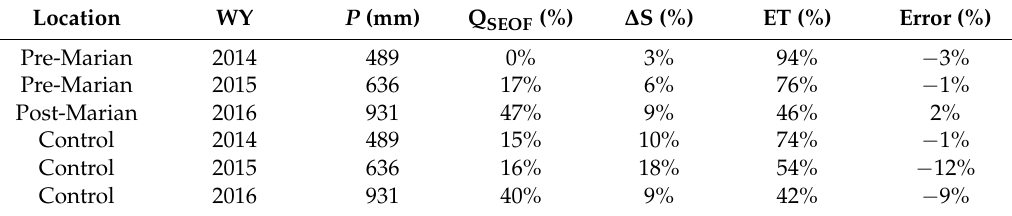
Table 4. Water budget percentage of precipitation for Marian and Control Meadows for pre-restoration 2014–2015 water years (WY) and one year following restoration by encroached conifer removal 2016